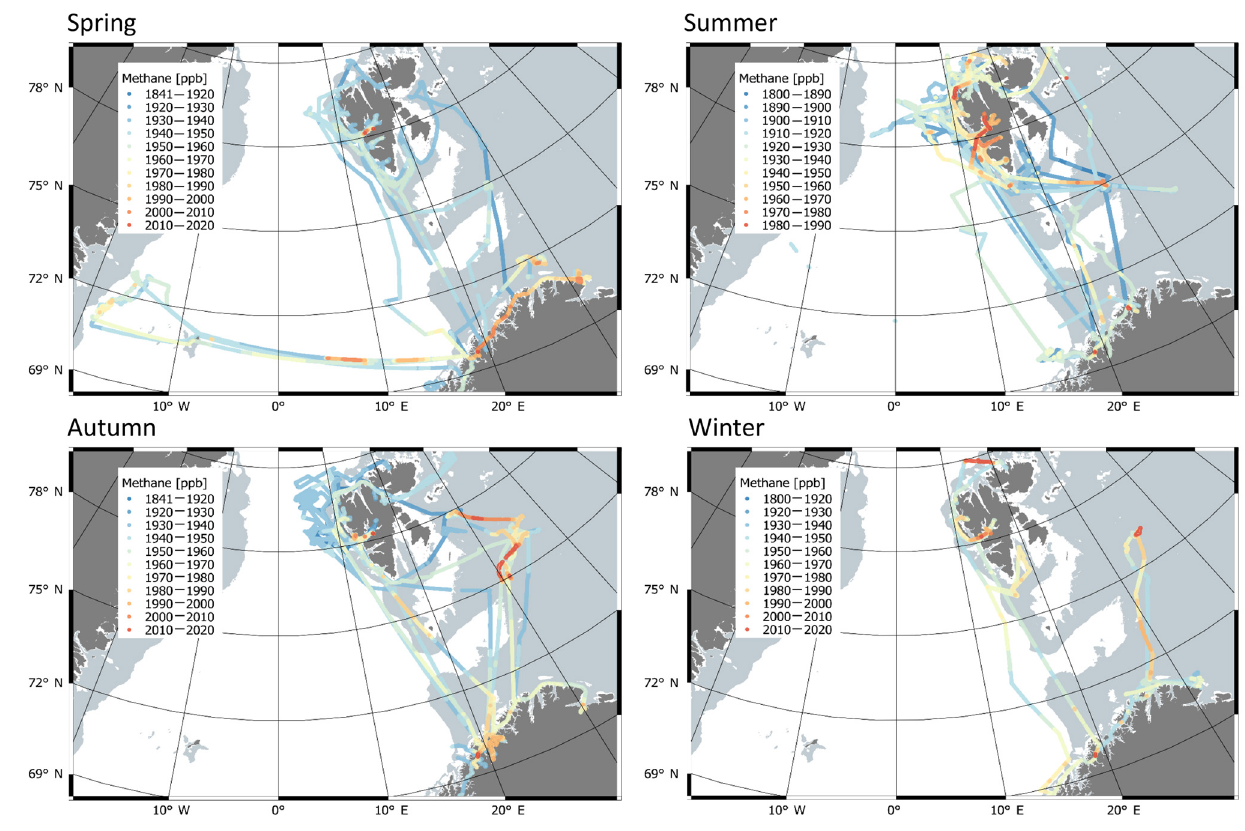
Figure 5. Methane mixing ratios observed at the RV Helmer Hanssen (colour scale), by location and plotted by calendar season (i.e. winter is December/January/February). Please note the change in colour scale between